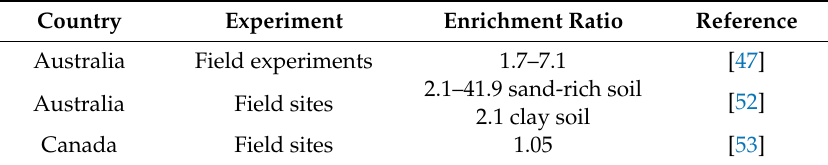
Table 4. The enrichment ratio of carbon in sediments derived from wind